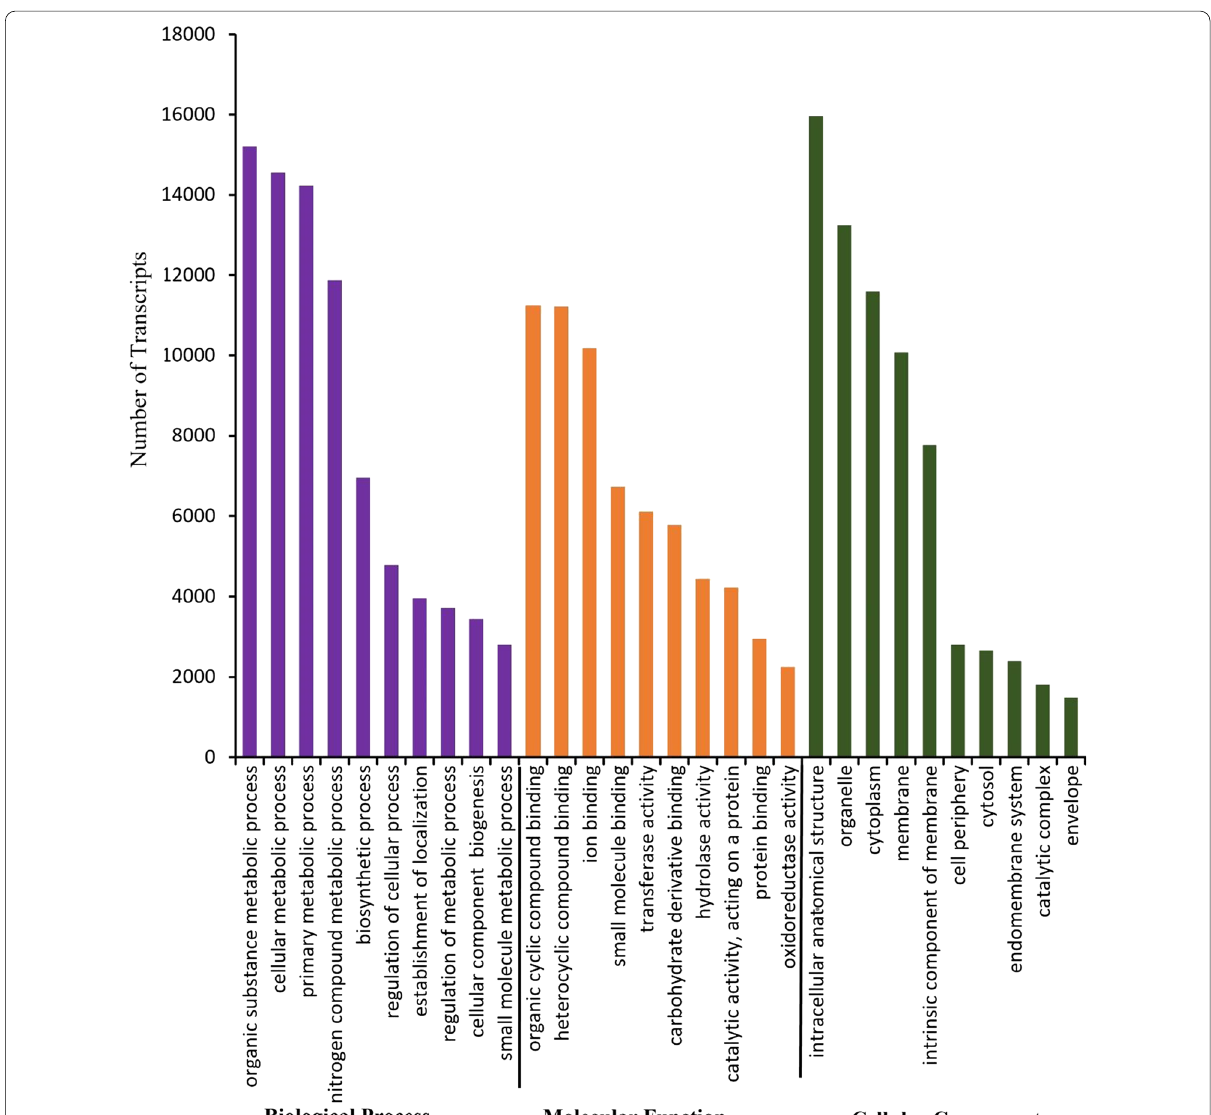
Fig. 5 Top ten GO terms represented by the highest number of transcripts for cellular component, molecular function, and biological process categories of gene ontology annotation for all aligned transcript